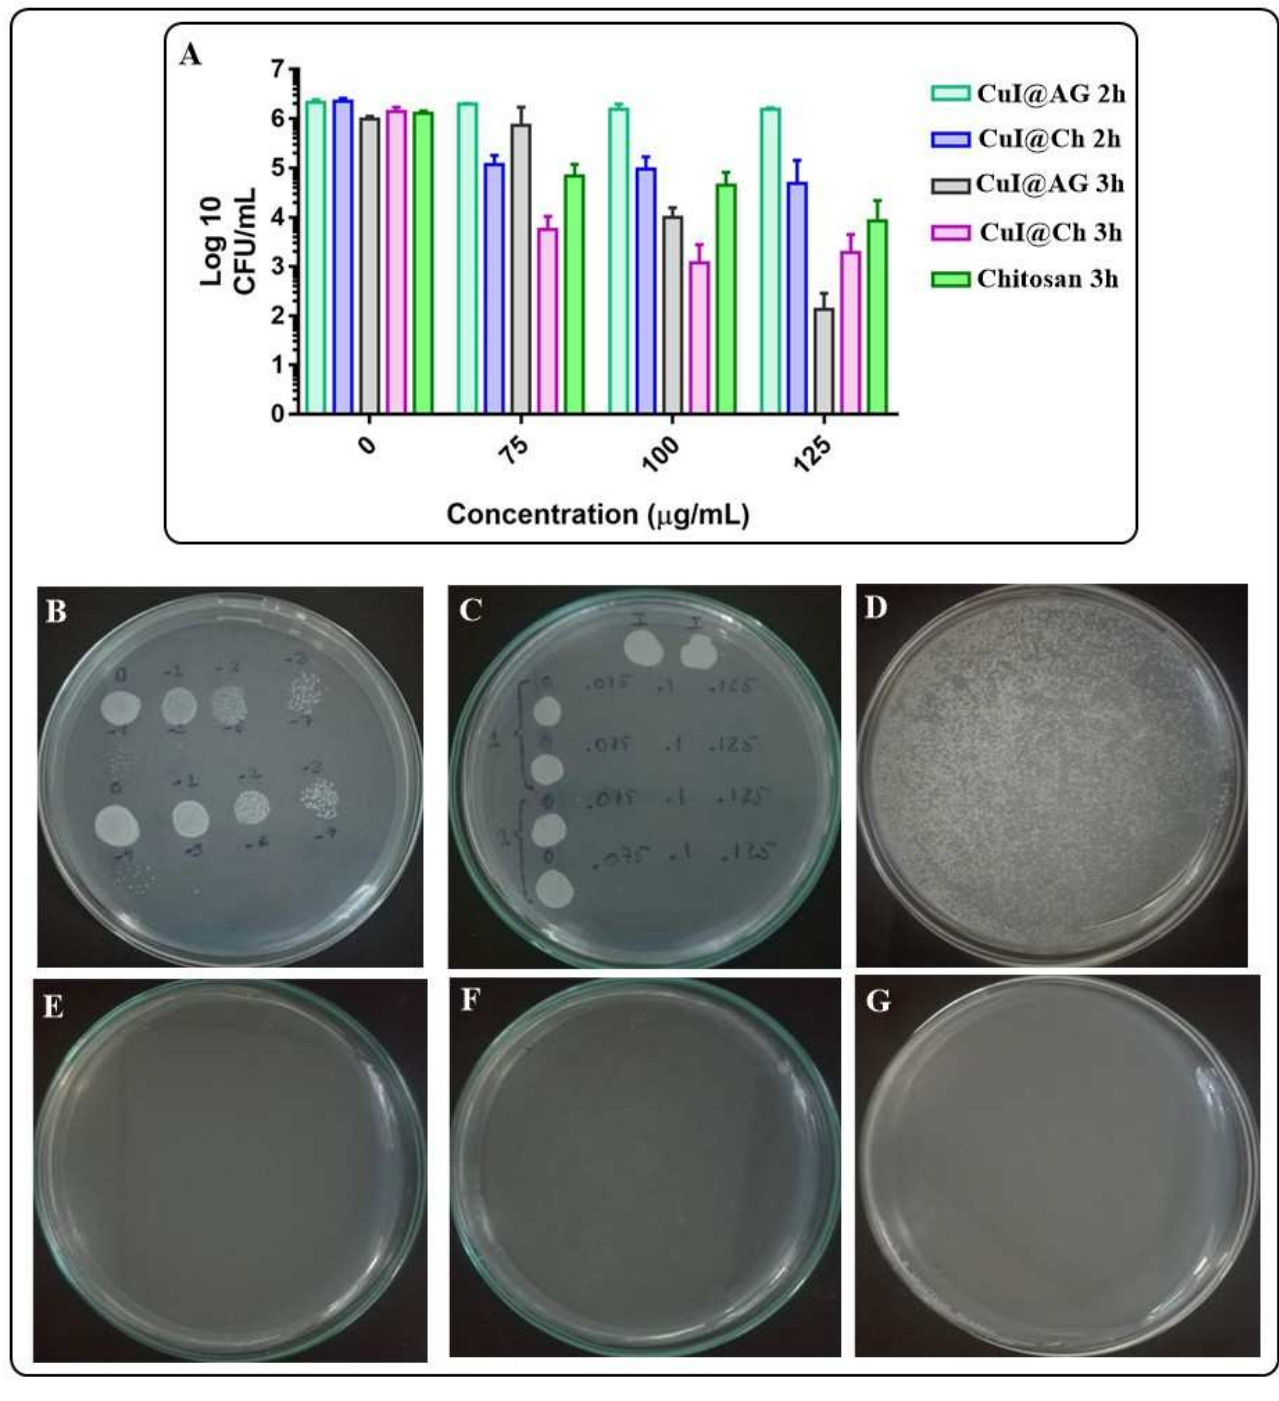
Figure 6. Evaluation of the antifungal activity of CuI@AG, CuI@Ch and chitosan to inhibit C. albicans growth. ( A ) Log reduction on the CFU/mL of C. albicans exposed to different amounts of CuI colloids or chitosan. ( B ) Viability of control group (decimal dilutions) under experimental conditions. ( C ) Evaluation of the fungicidal activity of CuI@AG against C. albicans (drop dilution test). ( D – G ) Enumeration of the CFU/mL of C. albicans exposed for 5 h to different amounts (0, 75, 100 and 125 µ g/mL) of CuI NMs (spread plate